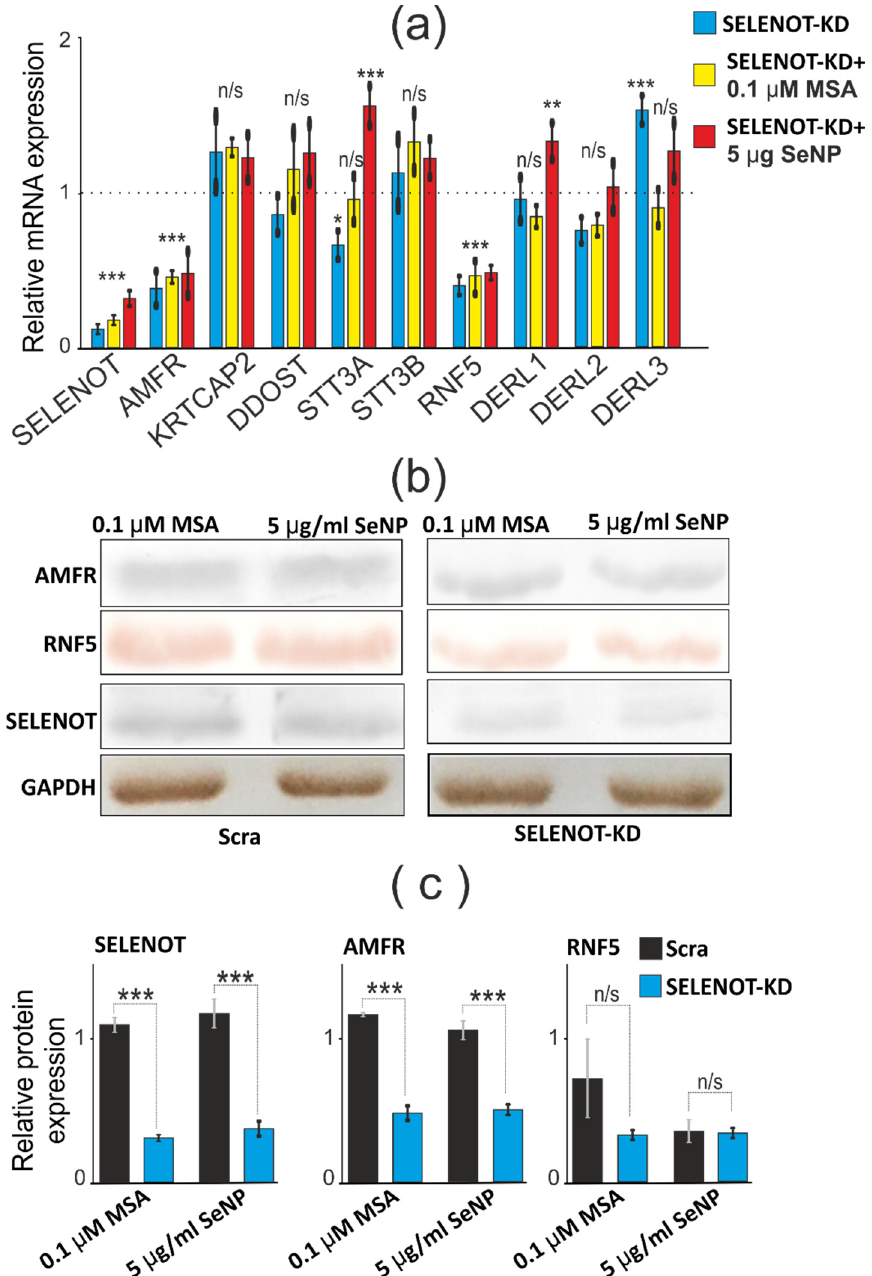
Figure 12. The effect of SELENOT-KD on the expression of SELENOT partner proteins under ER stress. ( a ) Comparative analysis of mRNA expression patterns of SELENOT proteins-partners under SELENOT-KD and without SELENOT-KD as well as under conditions of ER stress caused by 0.1 µ M MSA or 5 µ g/mL SeNP, obtained using real-time PCR. Comparison of experimental groups regarding control, indicated as dash line (1): n/s—data not significant ( p > 0.05), * p < 0.05, ** p < 0.01 and *** p < 0.001; ( b ) comparative analysis of the quantitative content of SELENOT proteins-partners, using Western blotting; ( c ) quantification of the content of SELENOT proteins-partners in A-172 cells transduced with SELENOT-KD and scrambled RNA (Scra) under conditions of ER stress caused by 0.1 µ M MSA or 5 µ g/mL SeNP. Comparison of SELENOT-KD vs. Scra: n/s—data not significant ( p > 0.05), *** p